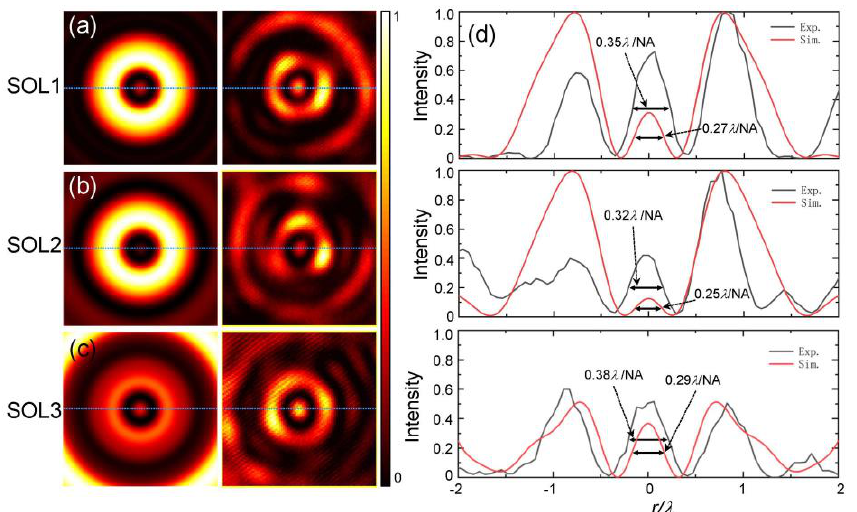
Figure 5. Experimental results of three superoscillatory metalenses. ( a – c ) Intensity distributions of the simulated and measured focal fields generated by metalenses with parameters of k r = 0.08 k 0 , 0.29 k 0 , and 0.43 k 0 ; ( d ) Normalized line-scan intensity profiles at the focal plane (indicated by dashed lines): simulation (red) and experiment (black).